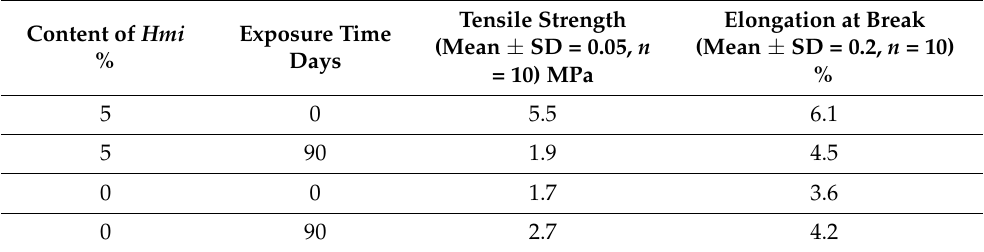
Table 4. Mechanical characteristics of the neat and weathered Hmi /PHB materials (90 days of expo- sure).